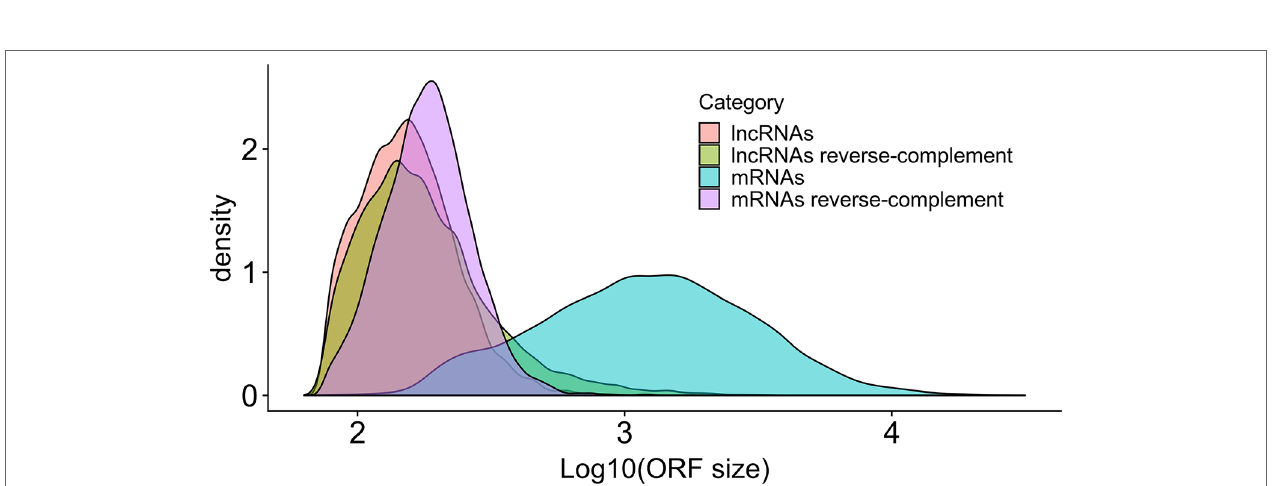
FIGURE 3 | Size distribution in S. mansoni of the longest canonical ORFs in lncRNAs and in mRNAs. The graph shows the density (y-axis) of the different sizes for the longest detected ORFs (in nucleotides, x-axis) of all lncRNAs (pink), of all mRNAs (blue) and of their reverse-complement sequences as controls (green and purple,